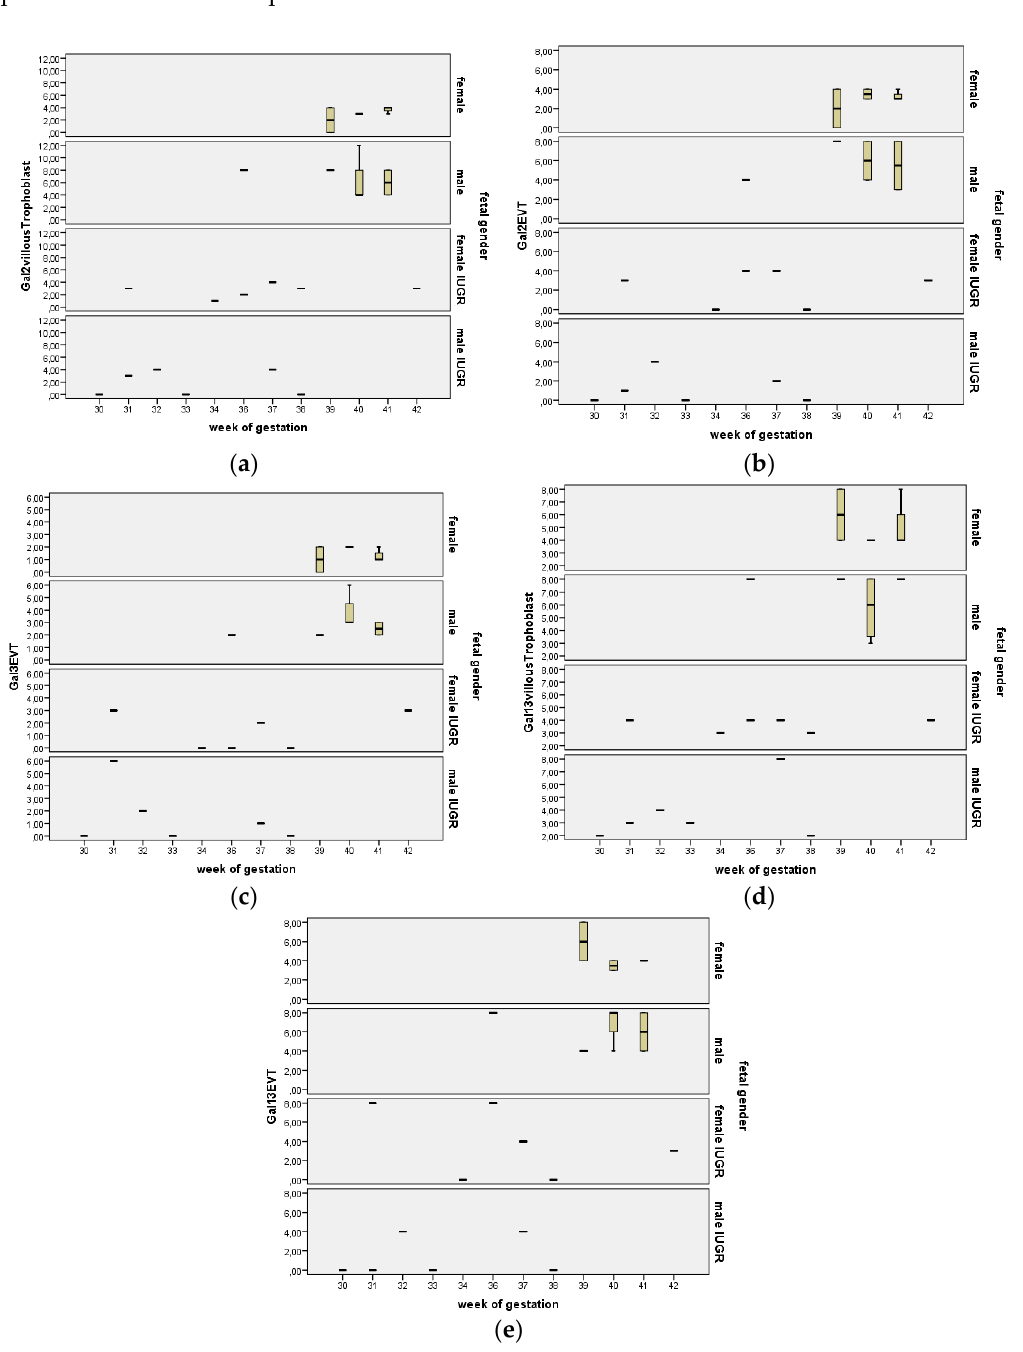
Figure 8. Stratification for gestational age does not reveal any dependency of galectin expression levels on progressing gestational age, as depicted for gal-2 in villous ( a ) and extravillous trophoblasts ( b ), for gal-3 in EVT ( c ) and gal-13 in both villous ( d ) and extravillous trophoblasts ( e ).